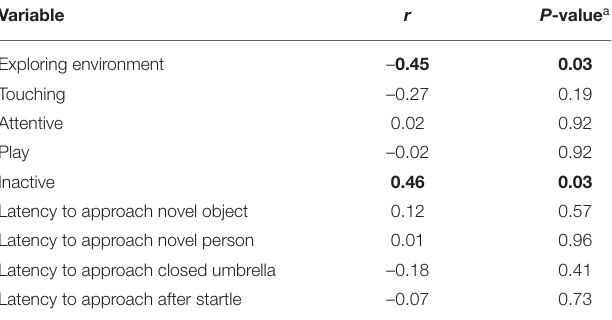
TABLE 4 | Pearson’s correlations between behavioral variables measured in each of the traditional personality tests (novel person, novel object and startle test) and total movement index measured in the isolation box test.